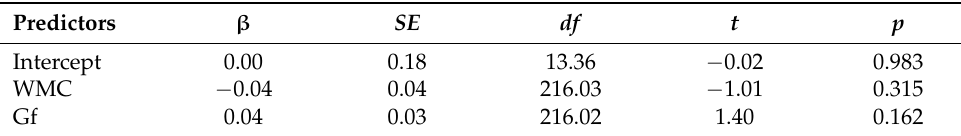
Table 5. Predicting RSJT different-version scores.